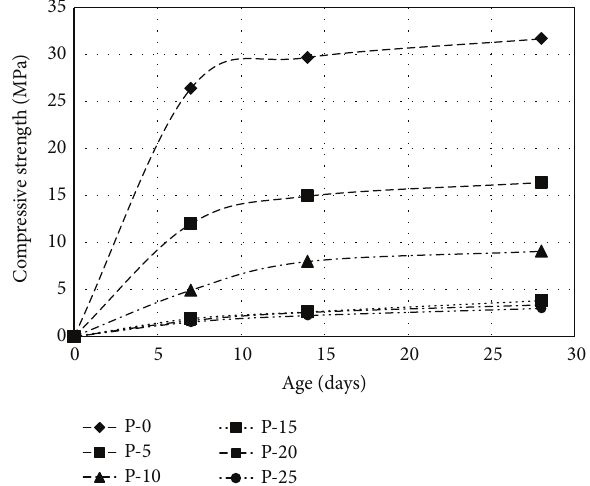
Figure 6: Effect of curing time on the compressive strength.